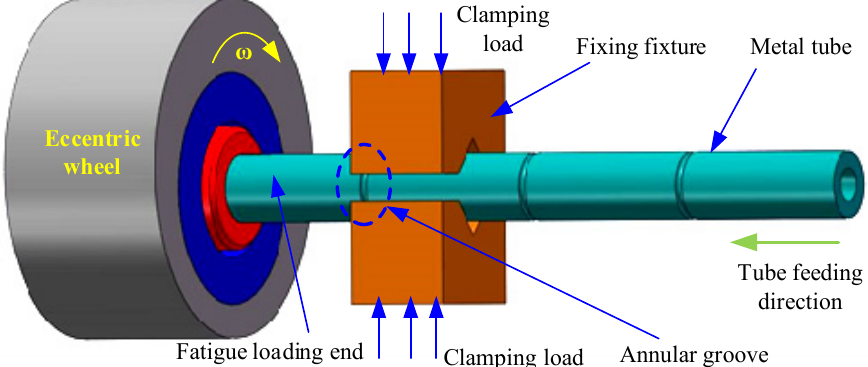
Figure 1. Schematic diagram of tubing eccentric wheel rotational bending fatigue loading.